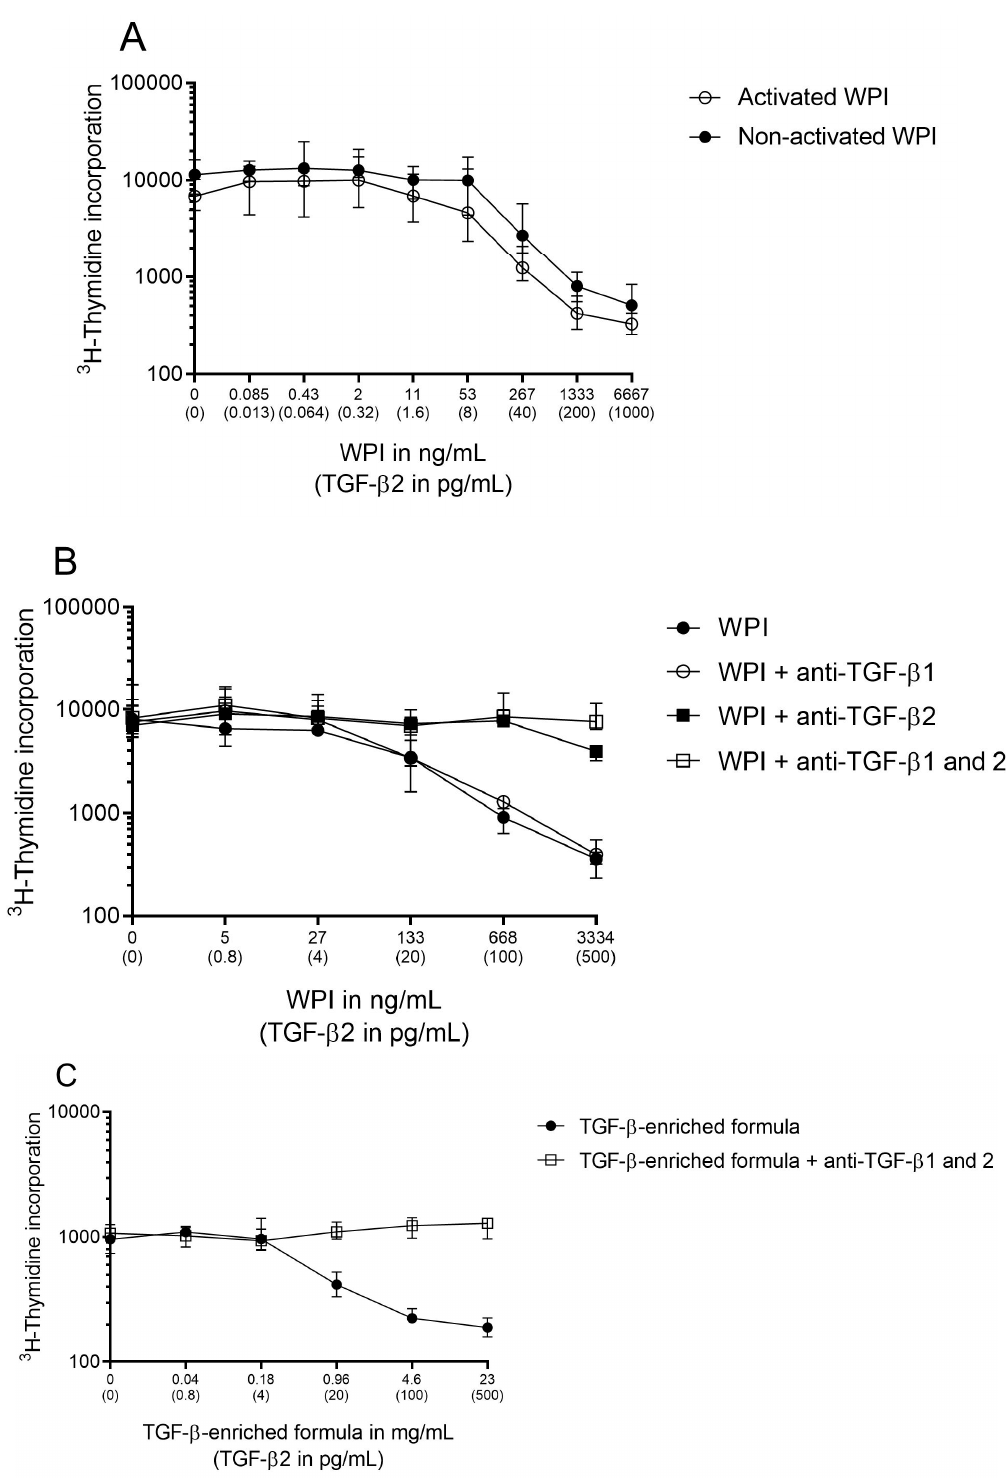
Figure 2. Effect of TGF- β on the inhibition of 3 H-thymidine incorporation in Mv 1 Lu cell cultures. Mv 1 Lu cells were incubated for 16 h (A) with serial dilutions of TGF- β -containing a WPI subjected or not-subjected to an activation step, (B) with or without anti-TGF- β 1 and/or anti-TGF- β 2, or (C) with serial dilutions of TGF- β